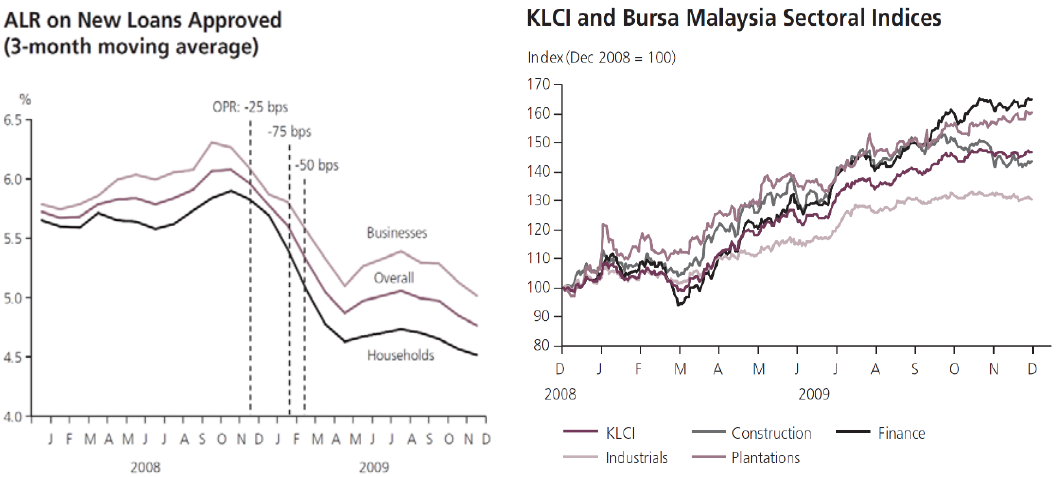
Figure 2. FTSE Bursa Malaysia Kuala Lumpur Composite Index. Source: Bank Negara Malaysia (2009). ALR—average lending rate; KLCI—Kuala Lumpur Composite Index; OPR—overnight policy rate.